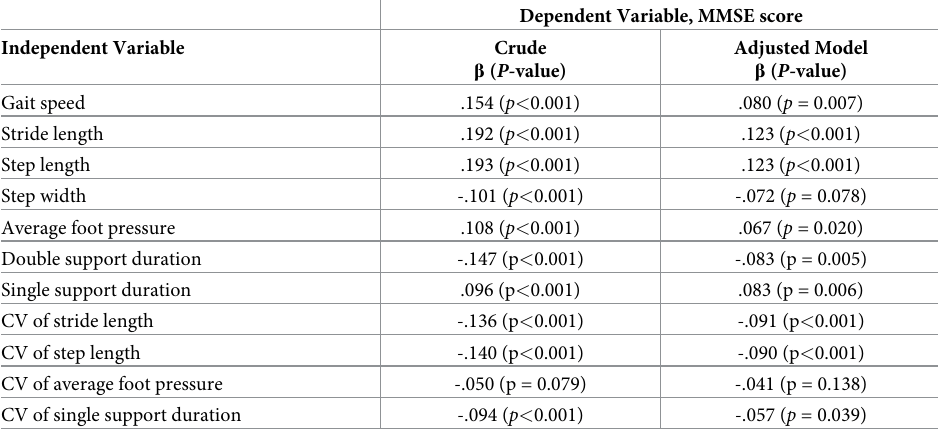
Multiple regression models with Bonferroni’s method were run separately. Model adjusted for sex, age, years of education, BMI, diastolic blood pressure, history of stroke, osteoarthrosis, disease of eye or ear, spinal canal stenosis, dementia, depression, and chronic knee